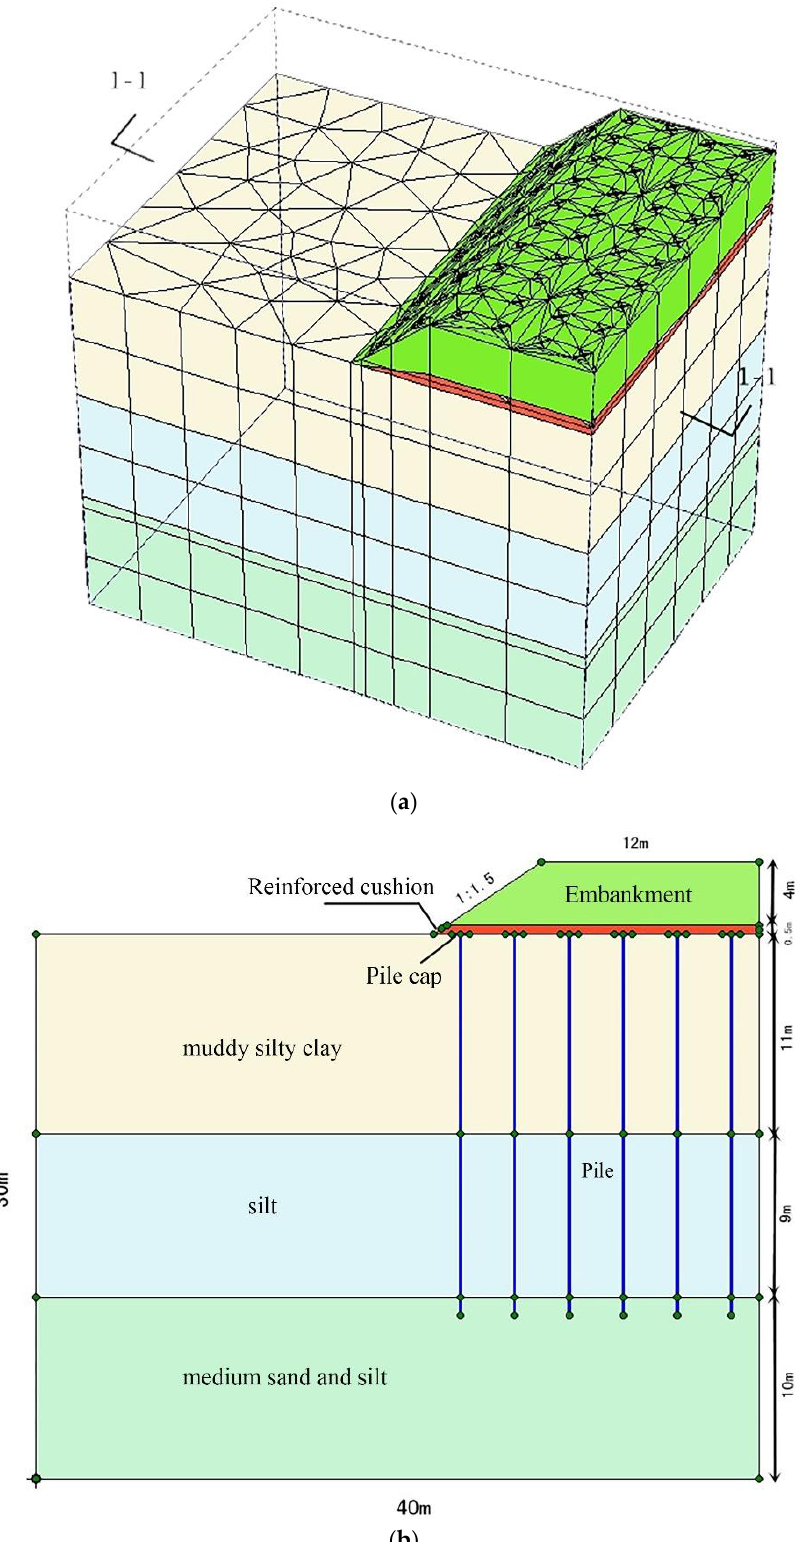
Figure 10. Numerical simulation graphics: ( a ) 3D geometric model; ( b ) geometric model of Section 1-1.